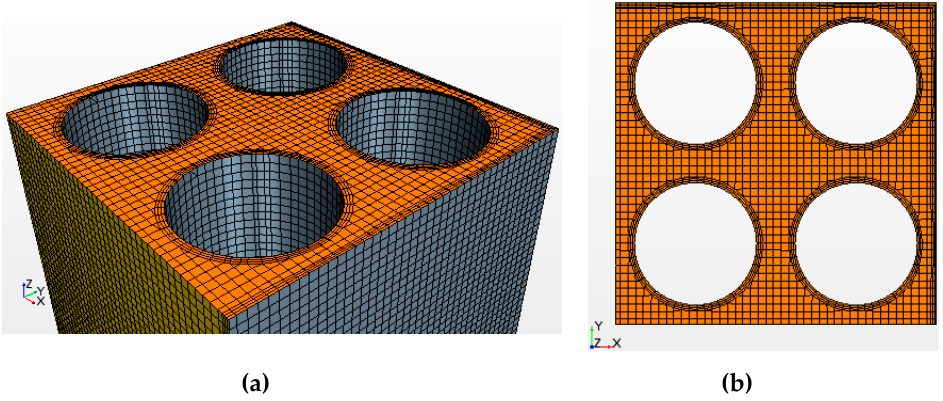
Figure 5. One-million-grid rod bundle: ( a ) 3-D near the outlet and ( b ) cross-section of the outlet.